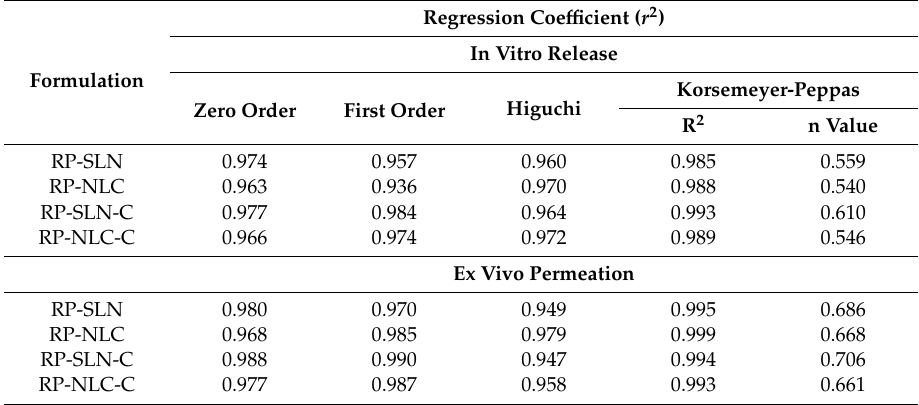
Table 4. Regression coe ffi cient values of RP-SLN, RP-NLC, RP-SLN-C and RP-NLC-C formulations from release kinetic mathematical models.